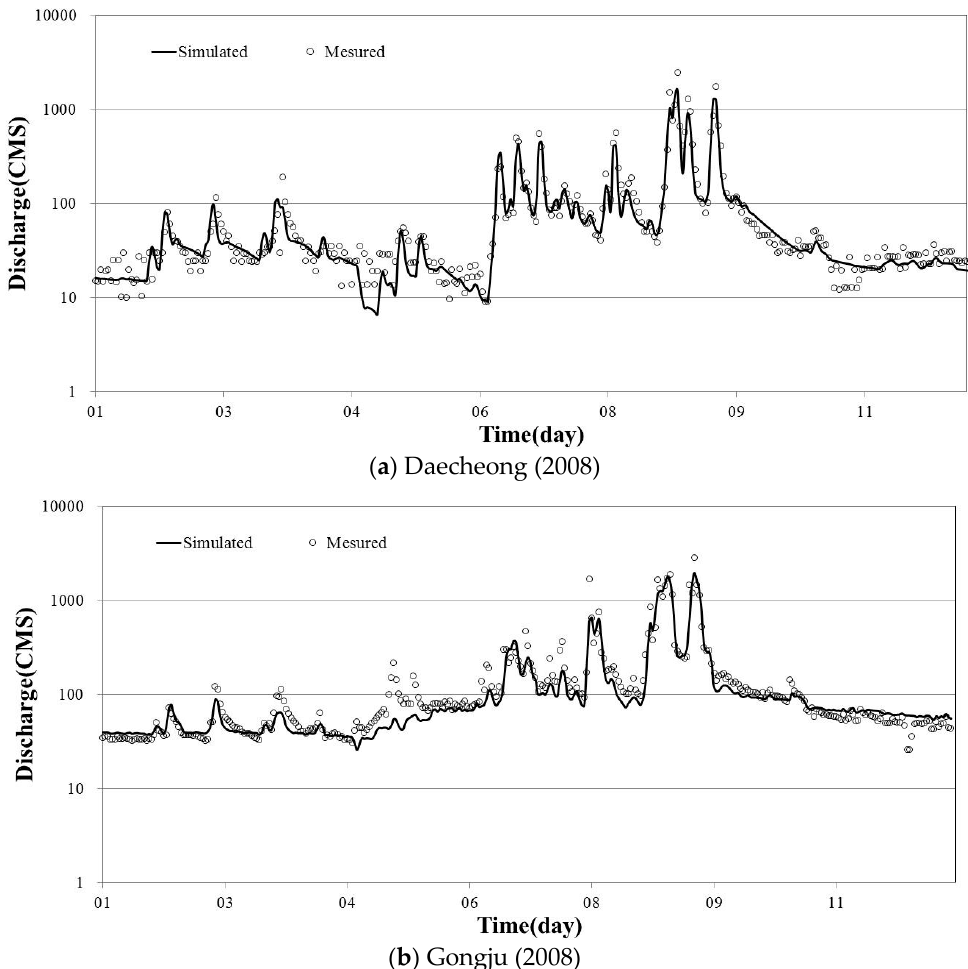
Figure 4. Examples of calibration results of the SSARR model.